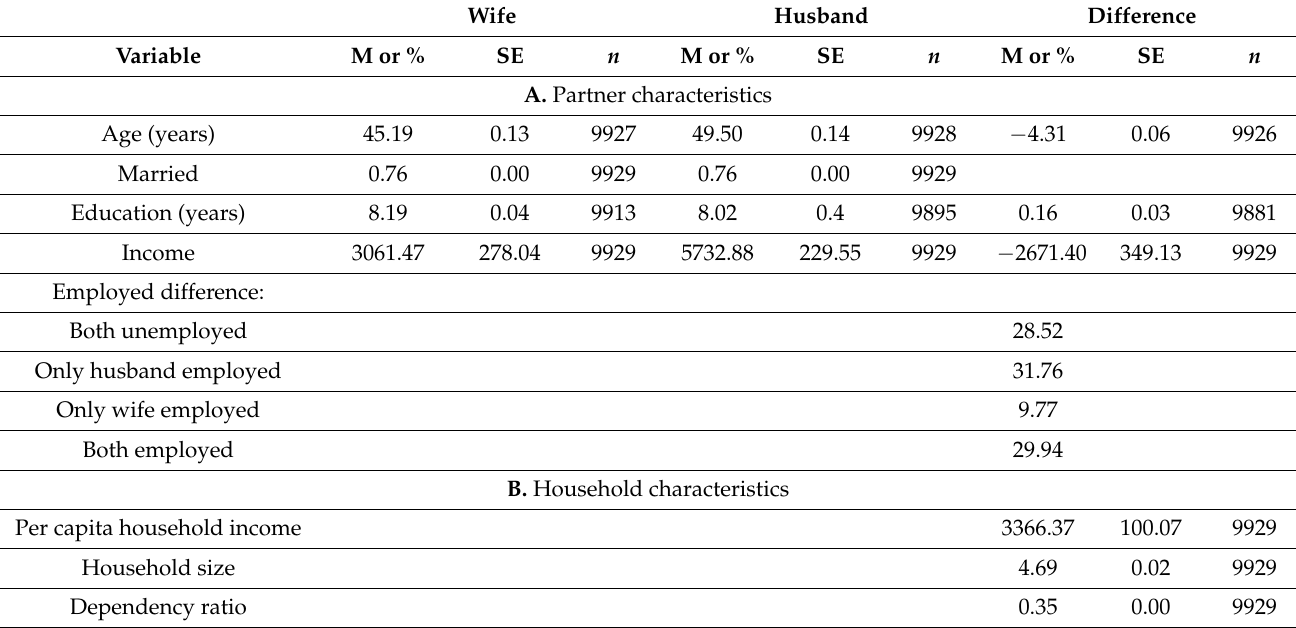
Table 2. Partner and household